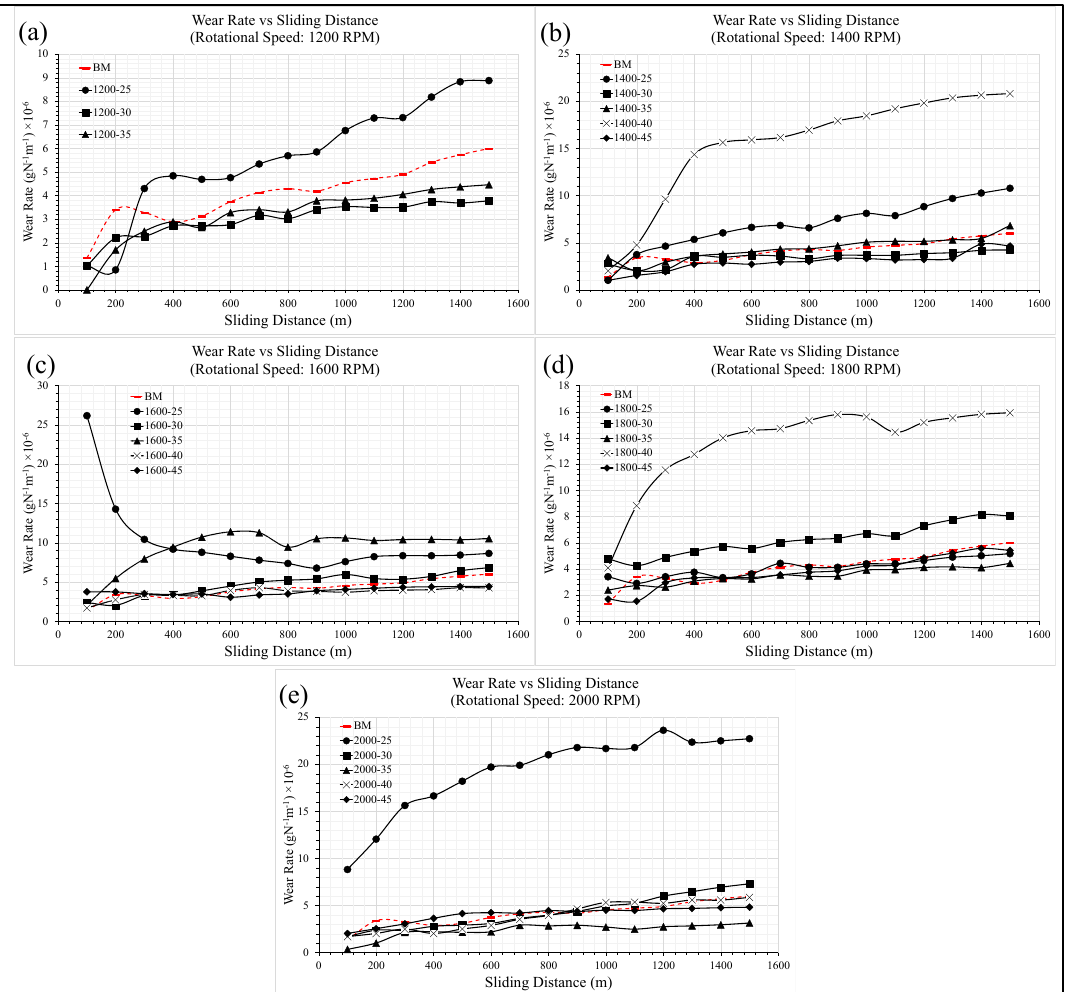
Figure 14. Wear rate vs. sliding distance for FSPed samples produced at ( a ) 1200 rpm, ( b ) 1400 rpm, ( c ) 1600 rpm, ( d ) 1800 rpm, and ( e ) 2000 rpm with different feed rate under starved lubrication con- ditions. (Normal contact pressure = 0.24 MPa, sliding speed = 2.88 m/s, total sliding distance = 1500 m).